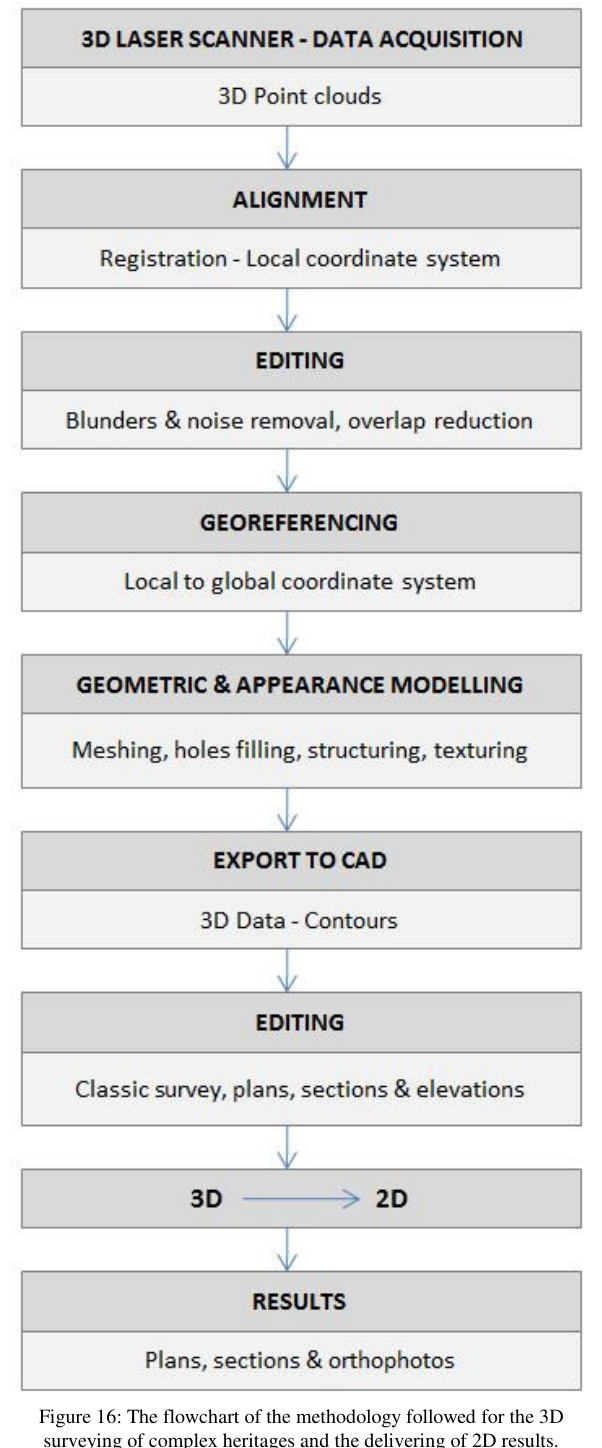
Figure 16: The flowchart of the methodology followed for the 3D surveying of complex heritages and the delivering of 2D results.